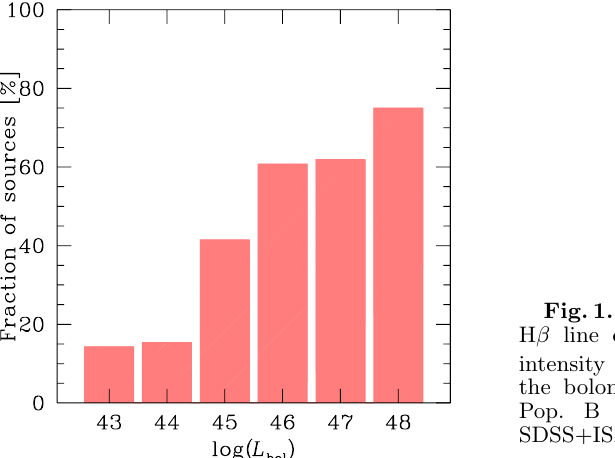
Fig. 1. Percentage of red-shifted H (cid:12) line centroids at 1 fractional 4 intensity ( c ( 1 )) as a function of 4 the bolometric luminosity for the Pop. B sources of the merged SDSS+ISAAC